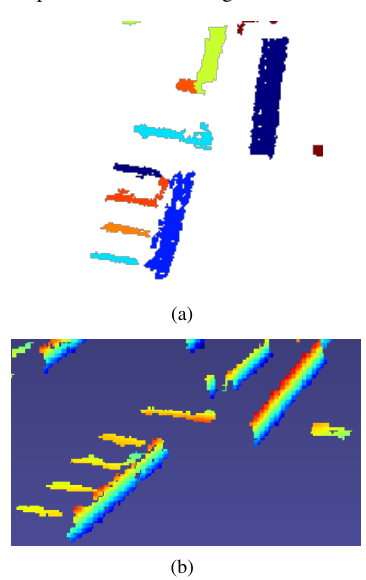
Figure 15: Segmentation result zoomed over the roof and facade areas of Figure 8. (a) Final segments (combined view of both high and low reflectivity areas). (b) 3D reconstructions of the corresponding building parts reprojected in the ( x, y, z ) geome-